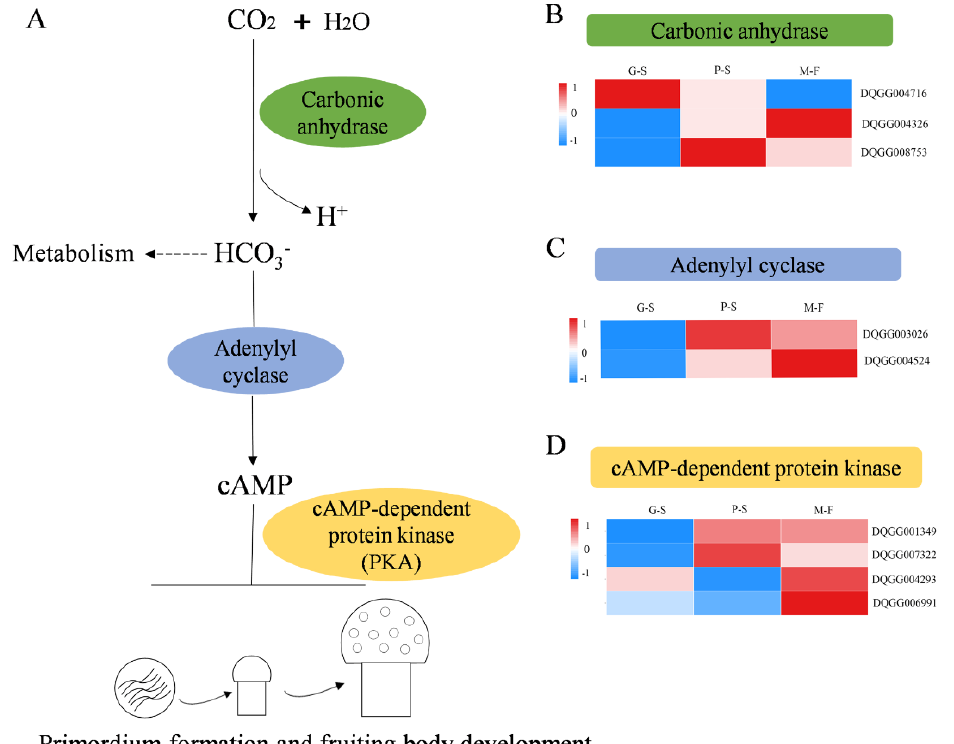
Figure 5. Expression patterns of carbon dioxide sensing-related genes: ( A ) schematic diagram of the involvement of carbon dioxide in the formation of primordia and development of fruiting bodies; ( B ) expression patterns of carbonic anhydrase genes; ( C ) expression pattern of adenylyl cyclase genes; ( D ) expression pattern of cAMP-dependent protein kinase (PKA) genes. The levels of expression are represented by log 2 (FPKM + 1) values after centralization correction.